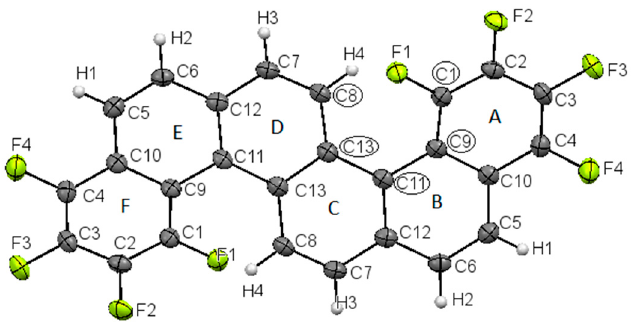
Figure 1. The molecular structure of 4a ; thermal ellipsoids were drawn on 50% probability level. Pale green ellipsoid represents F atoms.